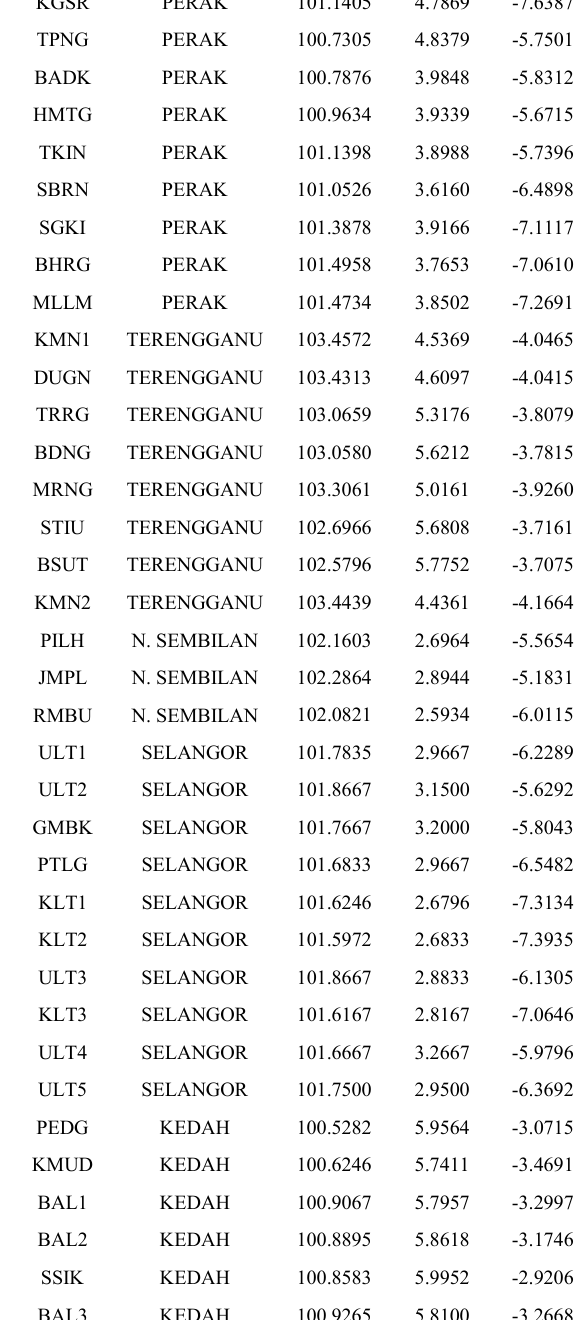
Table 2. The rate of change of GWS at JMG tube well from 2002 to 2017 3.5 Rate of GWS from 2002 until